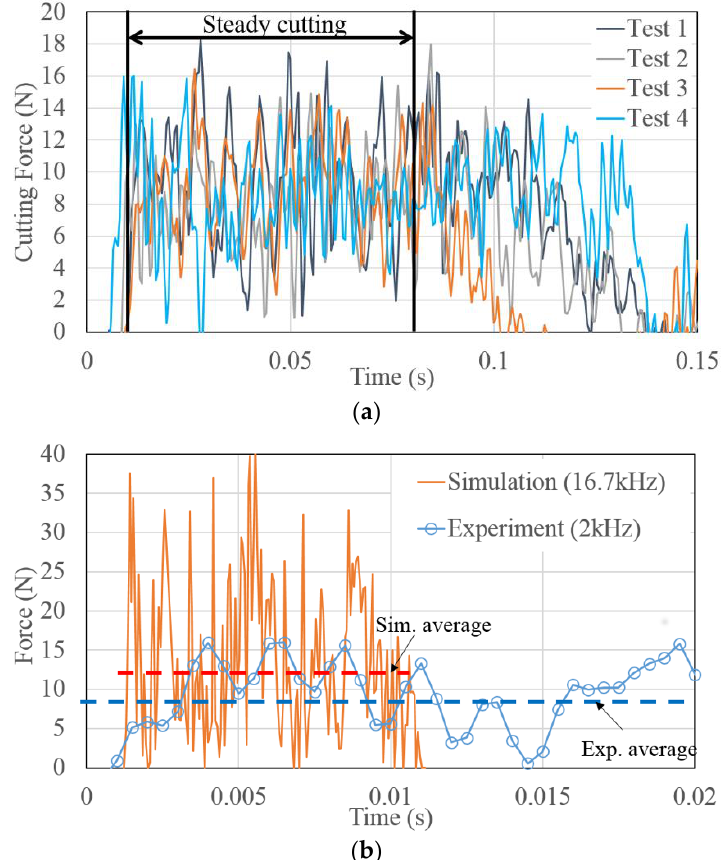
Figure 9. ( a ) Experimentally measured cutting forces of 30 pcf at DOC = 0.01 mm and ( b ) the comparison between the experiment and the simulated, scaled cutting force.